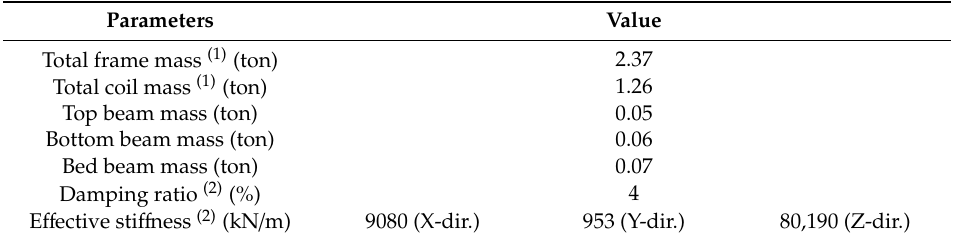
Table 3. Dynamic parameters of the mold transformer.